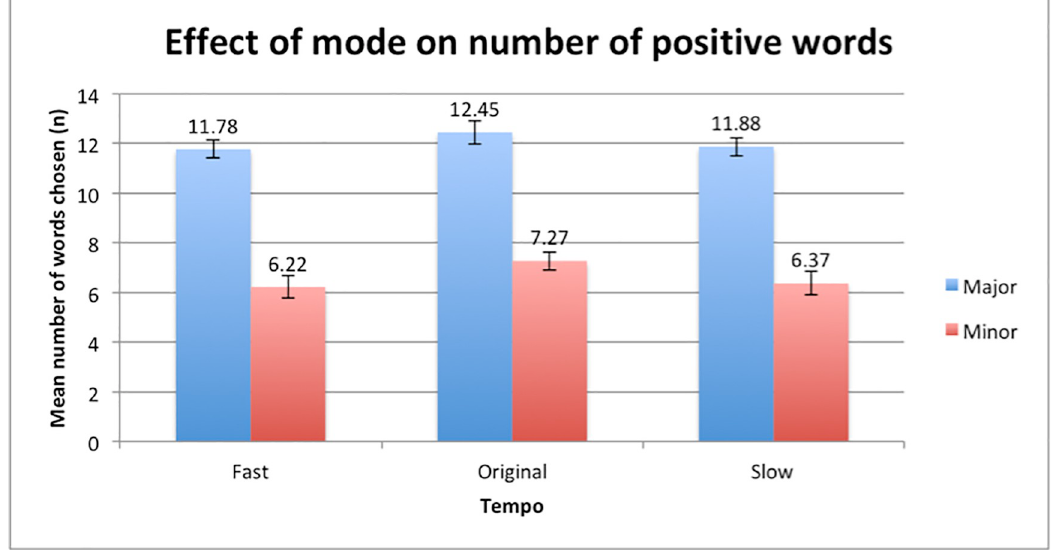
Fig 6. Differences in means of the selection of positive words between major and minor mode. Error bars indicate the standard error of the mean.